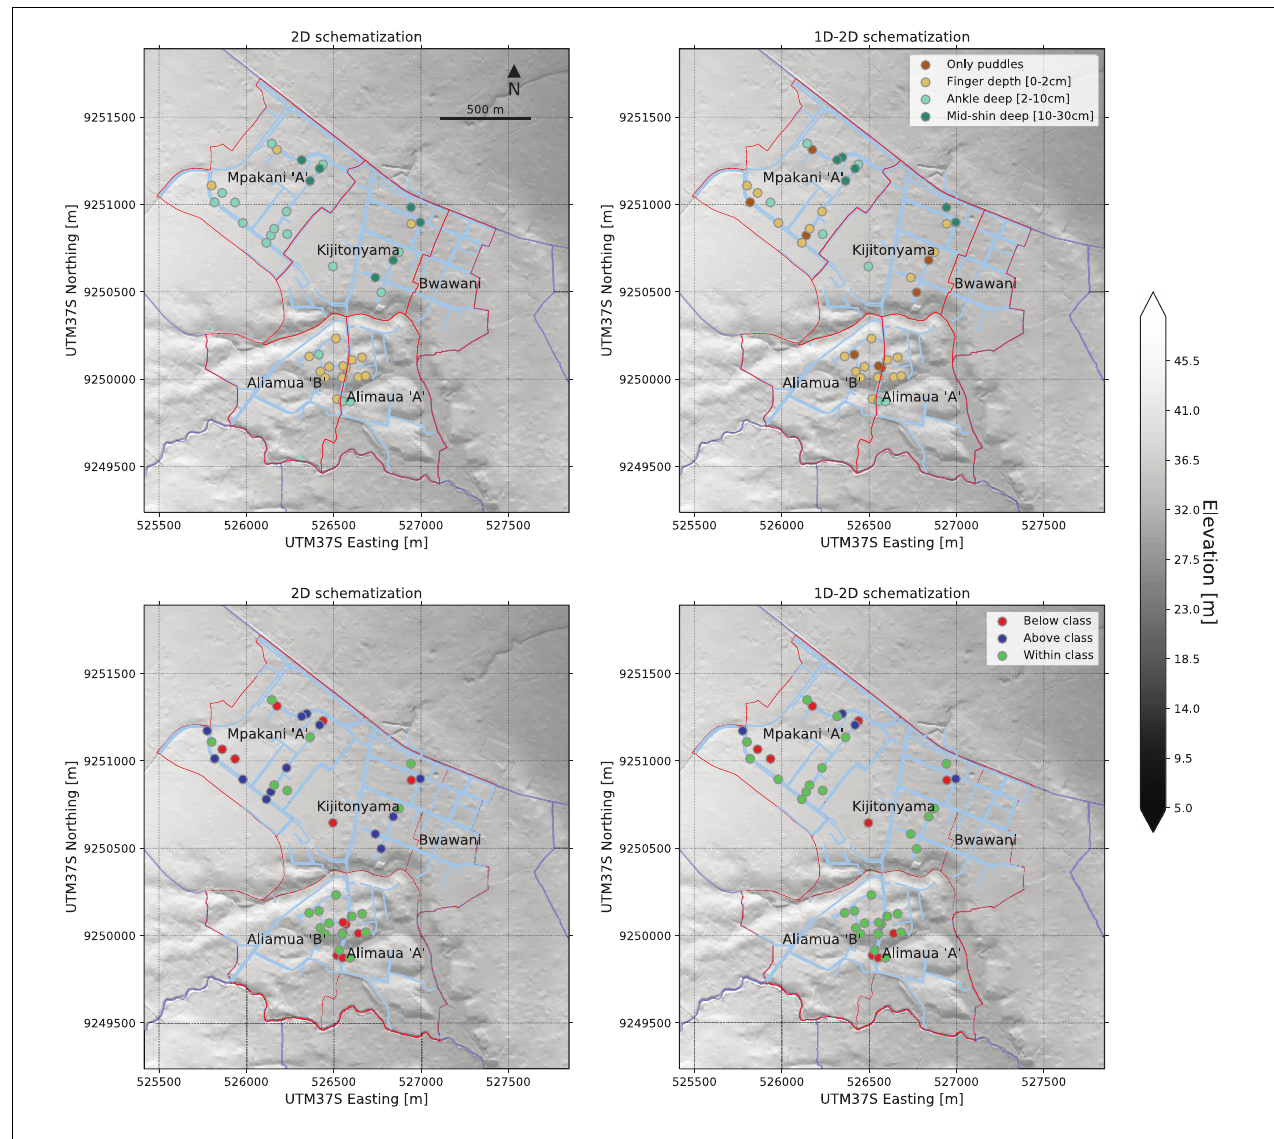
FIGURE 4 | Model results without (left) and with (right) community mapped data.